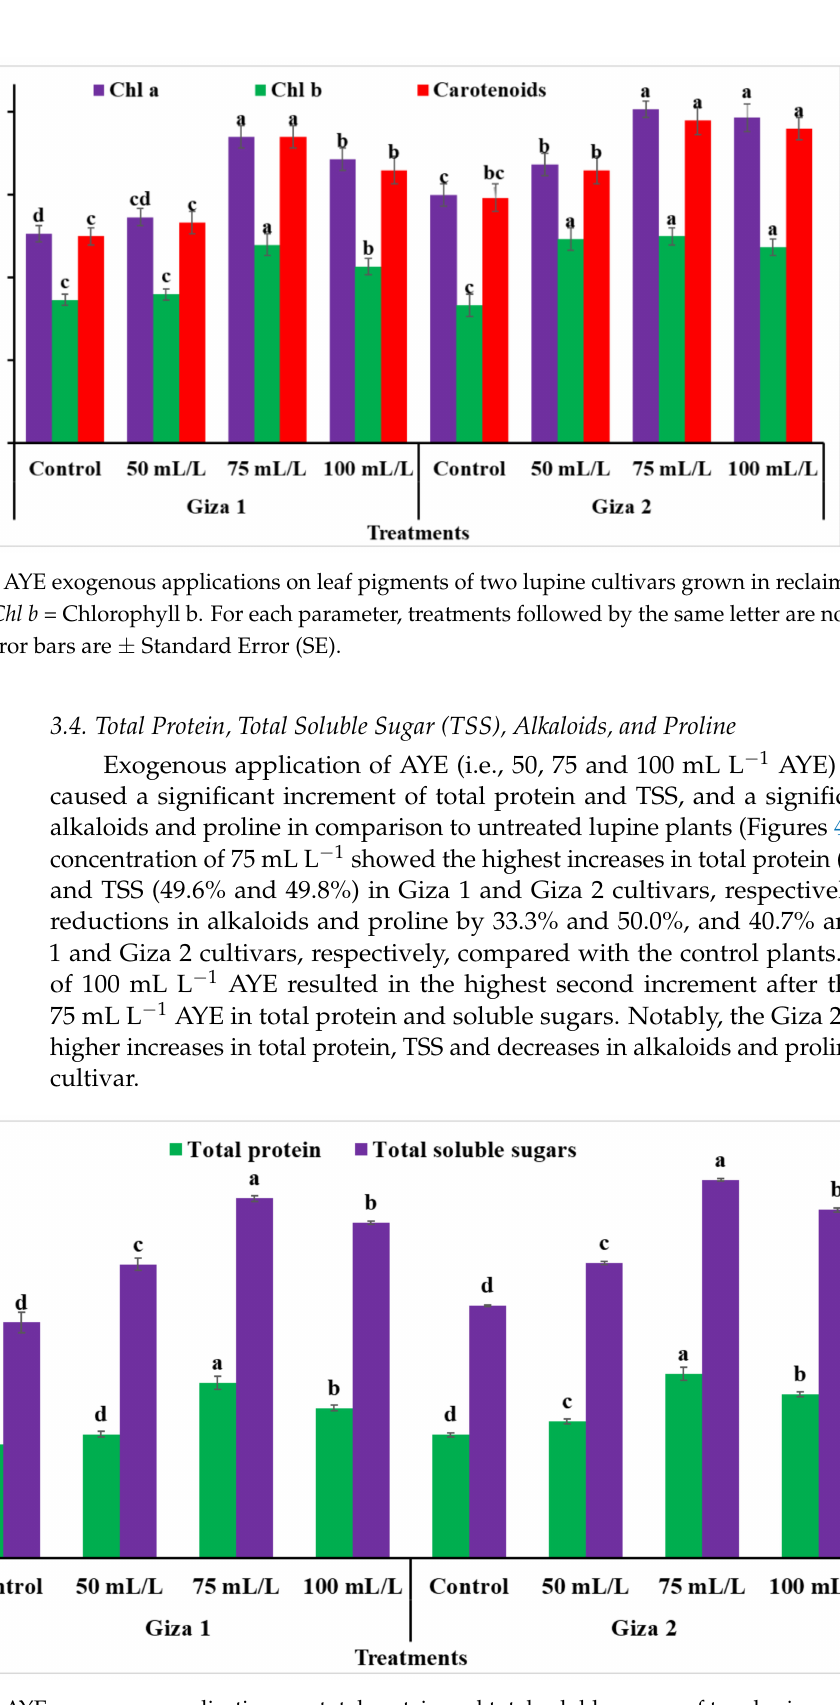
Figure 4. Effect of four AYE exogenous applications on total protein and total soluble sugars of two lupine cultivars grown in reclaimed-saline soil. For each parameter, treatments followed by the same letter are not significantly differed at p ≤ 0.05. Error bars are ± Standard Error